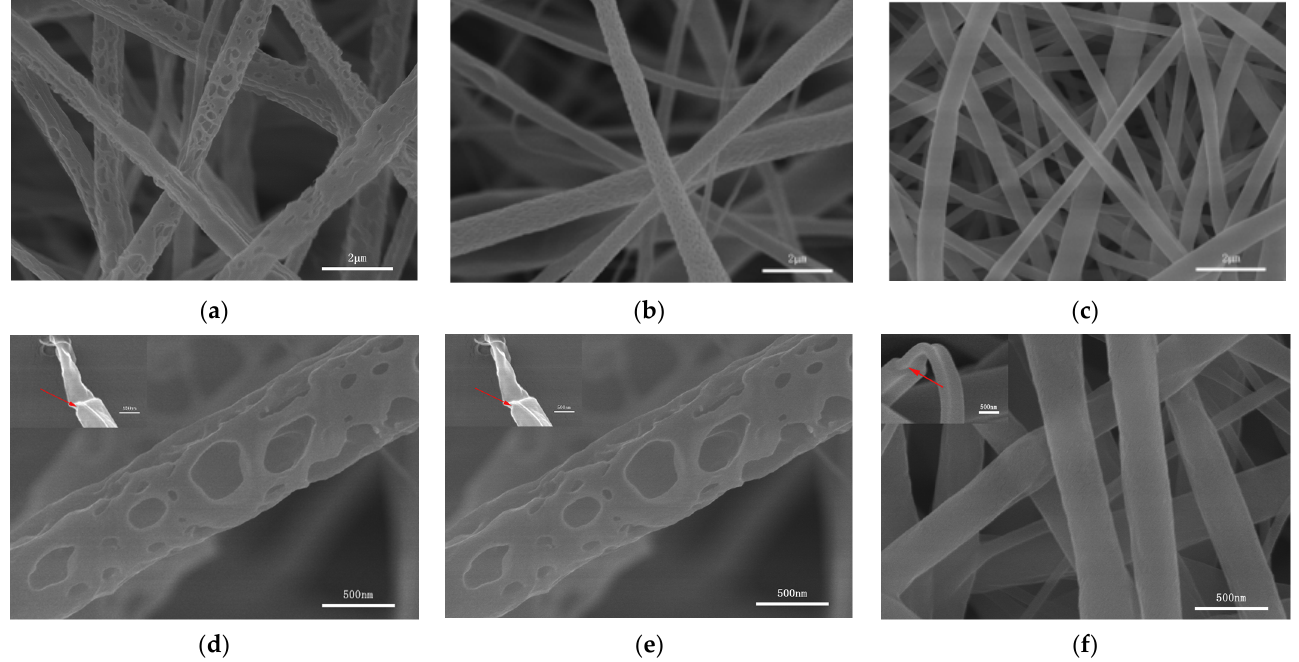
Figure 2. SEM images of the coaxial nanofibers: ( a , d ) PPR1, ( b , e ) PPR2, ( c , f ) PPR3. The red arrows highlight the coaxial structure.